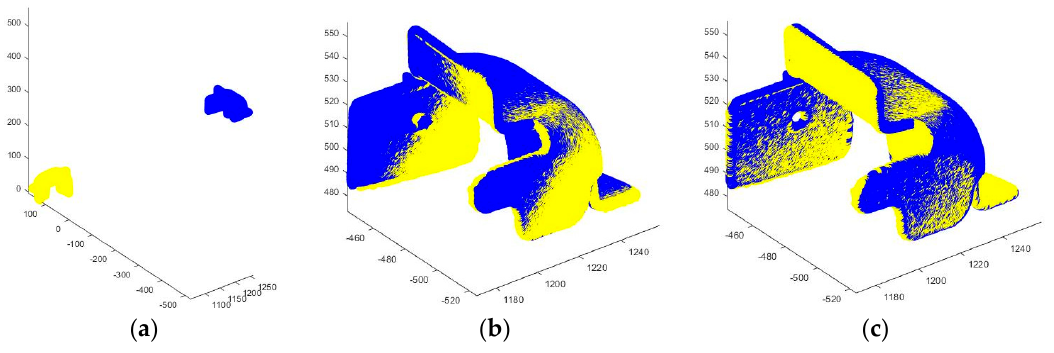
Figure 11. PCD after registration in Figure 10a. ( a ) is the initial position of the point cloud, ( b ) is